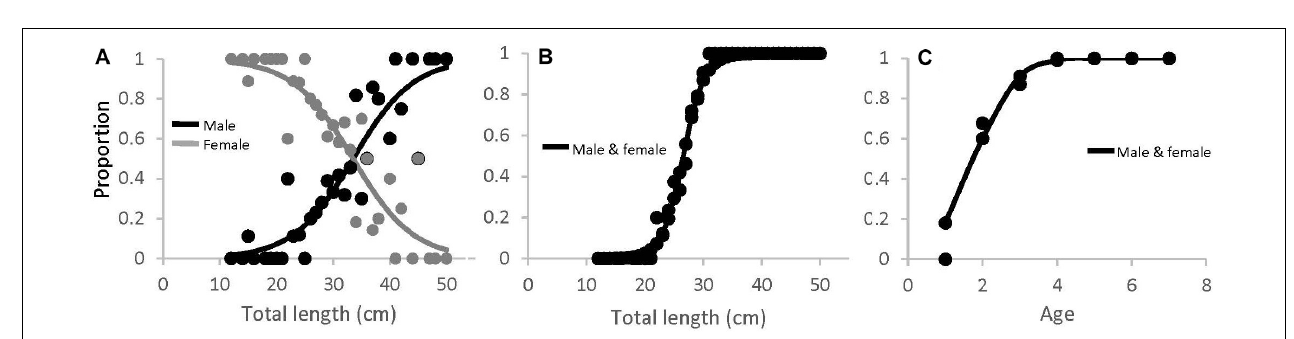
FIGURE 8 | (A) Proportion of male (black) and female (gray) black sea bass as a function of total length for all regions combined (M 50 = 33.5 cm), (B) length-at-maturity (L 50 = 26.6 cm), and (C) age-at-maturity (A 50 = 1.78 years) for all regions and sexes